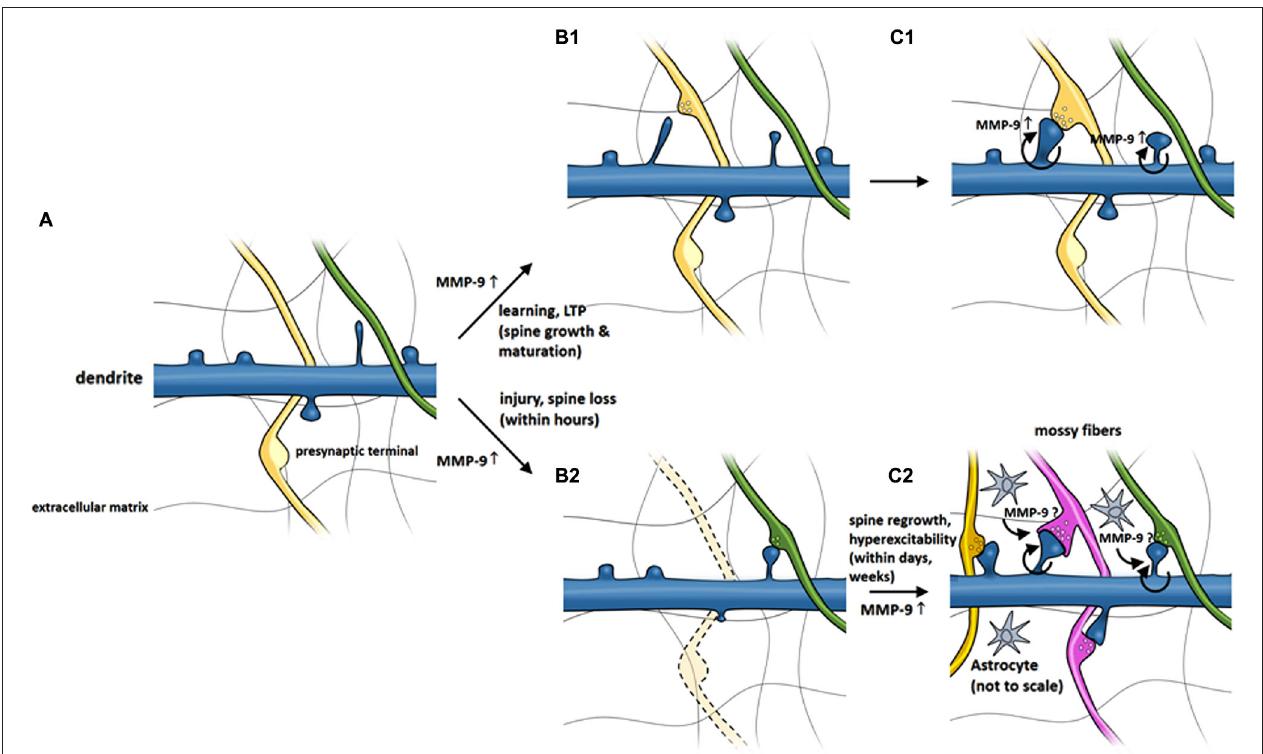
elongation and (C1) maturation. (B2) Fast (within minutes) activation of MMP-9 by injury or seizures may induce spine loss. (C2) Continuous increase of MMP-9 (secondary to seizures, within days) may cause regrowth of dendritic spines and contribute to long-term circuitry remodeling underlying